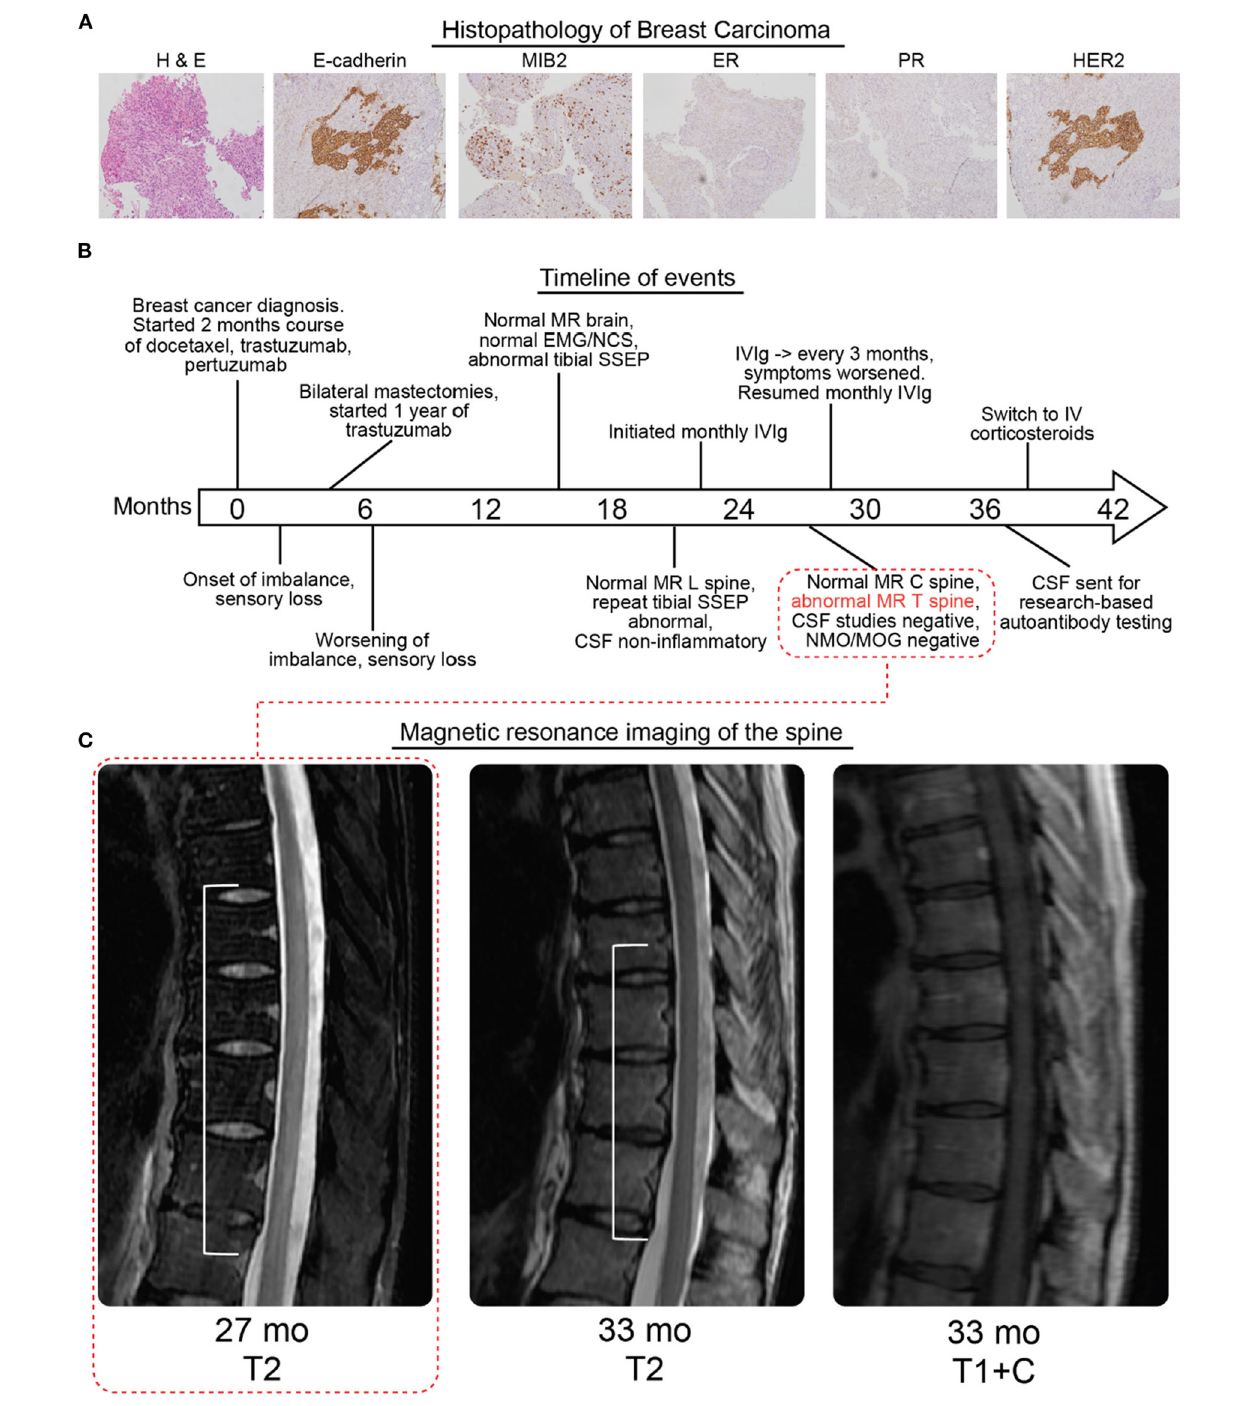
FIGURE 1 | Histopathology, timeline, and radiologic findings. (A) Hematoxylin and eosin staining (left panel) followed by molecular characterization of patient breast carcinoma (MIB2, mindbomb E3 ubiquitin protein ligase 2; ER, estrogen receptor; PR, progesterone receptor; HER2, Erb-b2 receptor tyrosine kinase 2). The carcinoma was rated as E-cadherein and MIB2 expressing, ER/PR negative, and HER2 positive. (B) Timeline of diagnosis, symptoms, imaging, electrodiagnostic studies, and treatment. Imaging corresponding to 27 weeks is indicated in the first subpanel one of (C) . (C) MRI of the spine without gadolinium at 27 months showed a dorsally predominant T2 hyperintense signal spanning T5–T10. At 33 months there was some improvement with the T2 hyperintense signal now spanning T7–T10 which was not contrast enhancing (additional views and brain MRI in Supplementary Figure 1 ). All times are relative to the initial diagnosis of cancer, neurological symptoms began 2 months after the cancer